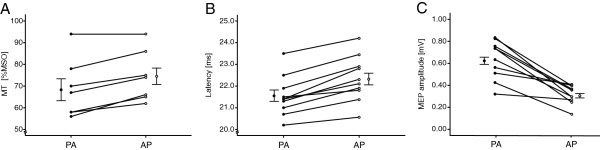
Individual differences in resting motor threshold (RMT), mean MEP amplitude and mean MEP latency depending on the direction of the induced current in M1-HAND (Experiment 1, n = 10 for MEP and latency, n = 7 for RMT). MEP were recorded from relaxed left APB muscle. MEPs were evoked with single-pulse TMS using a half-sine wave stimulus and a suprathreshold stimulus intensity to elicite mean MEP amplitude of 0.5 mV (SI0.5mV). (A) The resting motor threshold expressed in % of MSO was consistently lower for PA as opposed to AP stimulation. (B) Mean MEP latency of left APB was consistently shorter for PA as opposed to AP stimulation. (C) Mean MEP amplitudes of left APB were consistently larger for PA stimulation. PA: Half-sine wave stimulus inducing a posterior-anterior current in M1-HAND, AP: Half-sine wave stimulus inducing an anterior-posterior current in M1-HAND. Error bars indicate mean ± standard error of the mean.